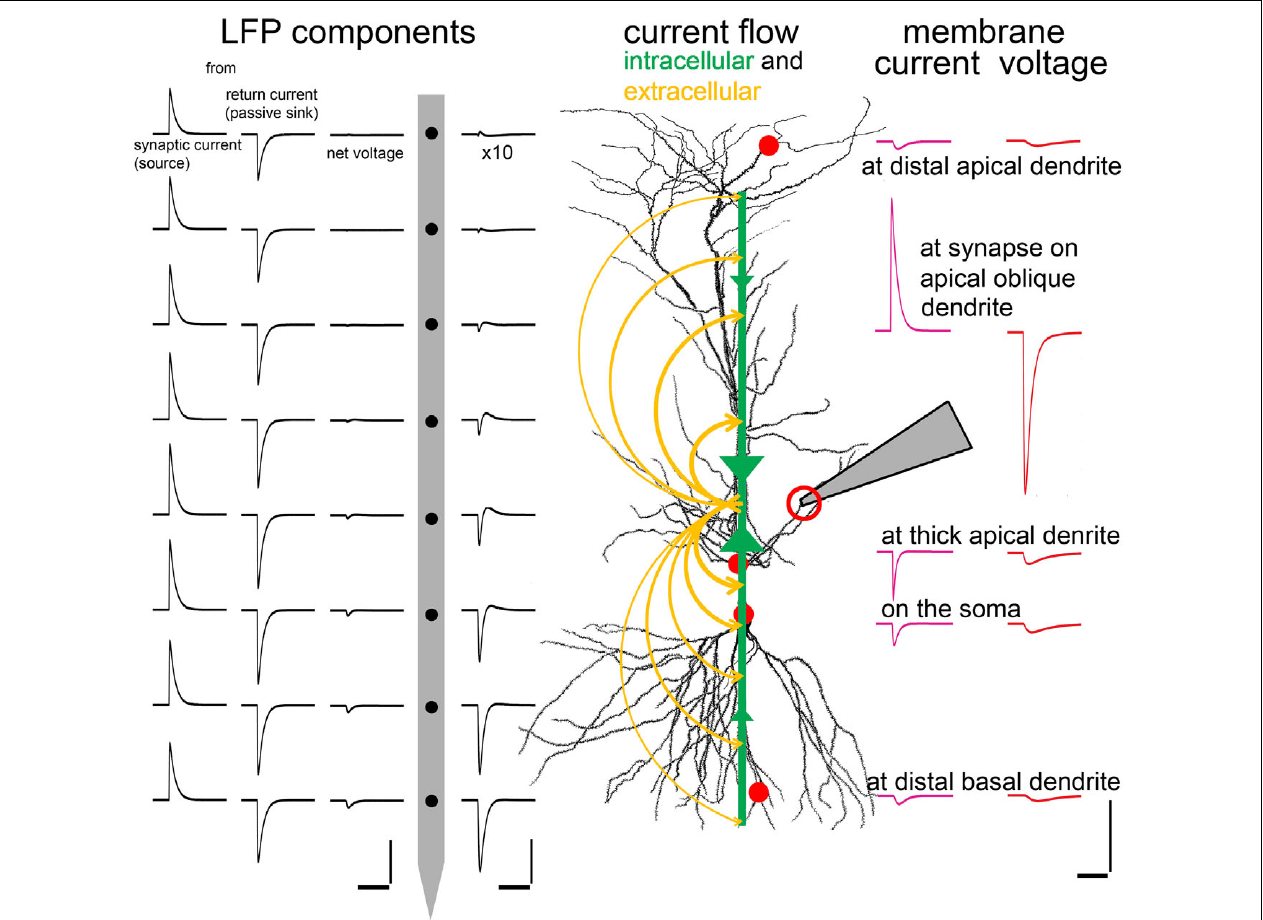
FIGURE 9 | Interactions among intracellular and extracellular signal components. To demonstrate the intra- and extra-cellular spread of synaptic currents, a realistic inhibitory conductance (an active current source from an extracellular point of view) was simulated on a second order oblique dendrite of a multicompartmental CA1 model PC in str. radiatum, at the position indicated by the pipette and the red circle. Green arrows show the flow of intracellular current toward the synapse. Yellow arrows show the return extracellular currents (sinks) satisfying Kirchhoff’s current law. The current density drops away from the synapse. On the right side of the cell the intracellularly recordable potential (red) and membrane current (purple) are shown at different characteristic locations. Note that the current density ( I m ) is very large at the synapse due to its localized nature (red circle), and the local membrane potential change ( V m ) is also large due to the location of the synapse in a relatively high resistance, small, second order dendrite. Current and voltage transients attenuate away from the injection site. While the local potential change is negative at each location (red circles) the current reverses polarity as we move away from the site of the localized, large active current to the locations of the spread-out, passive counter-currents. On the left of the cell the extracellular signal elements are visible: the leftmost and the second column show the virtual voltage changes that would be evoked by active and passive currents, respectively, recorded with a virtual electrode array at regular intervals (100 µ m). The third column shows the net LFP, which is equal to the summed voltage contributions of active and passive currents. Note that the large amplitude components very effectively cancel each other, so the layer-specific voltage differences can only be seen at 10 times magnification in the fourth column (between the electrode and the cell). The distribution of the voltage is asymmetrical because the majority of the return current is through the perisomatic area rather than the more distal apical dendrites. Therefore the “center of gravity” of the passive currents is shifted basally, forming a current dipole with the synaptic current, and producing an asymmetric voltage distribution. Scales: time scale is 20 ms for all scales, left: 5 × 10 − 4 µ V, center: 5 × 10 − 5 µ V, right: 0.05 pA/ µ m 2 and 0.5 mV, respectively, for the current and voltage